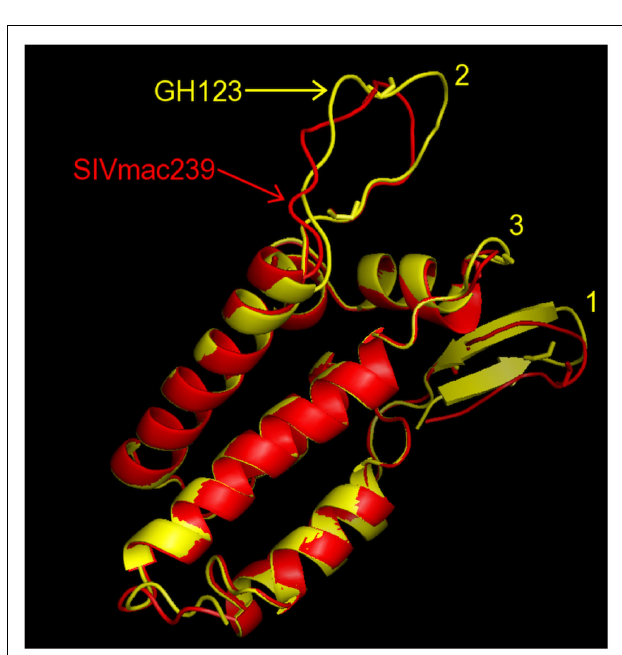
FIGURE 1 | (A) Sensitivities of HIV-2 GH123, HIV-2 GH123 mutant carrying SIVmac239 capsid protein (HIV-2 GH/SCA), and SIVmac239 to cynomolgus (CM) and rhesus (Rh) monkeyTRIM5 α .The replication of HIV-2 GH123 was potently restricted by CM and RhTRIM5 α (sensitive), while that of SIVmac239 and the HIV-2 GH123 mutant carrying